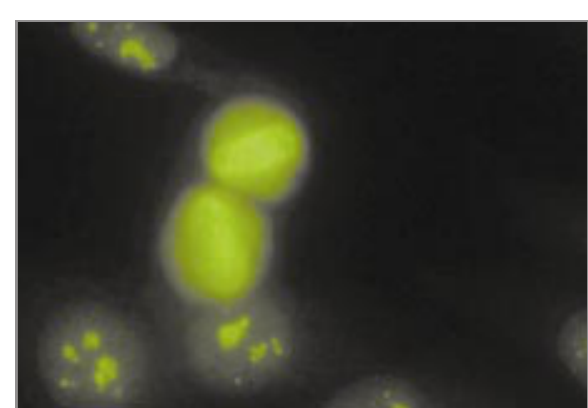
Figura 8 – Nuclear pontilhado centromérico